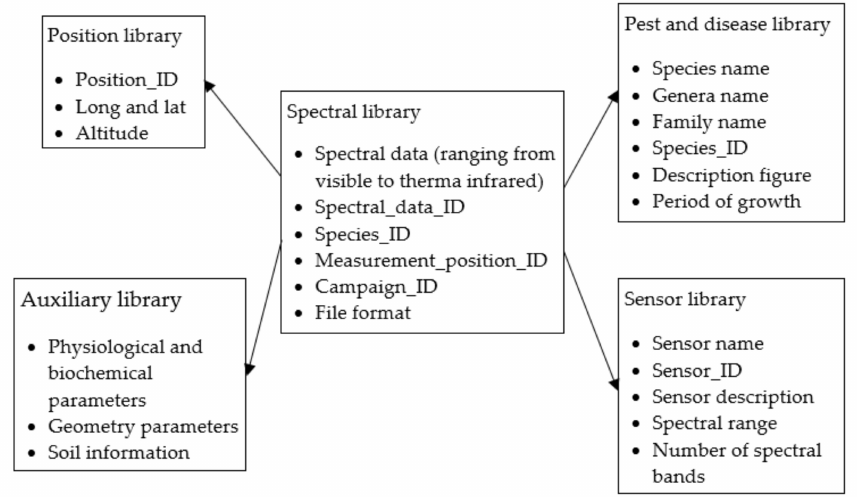
Figure 8. The data model of Spectral Library System of pests and species